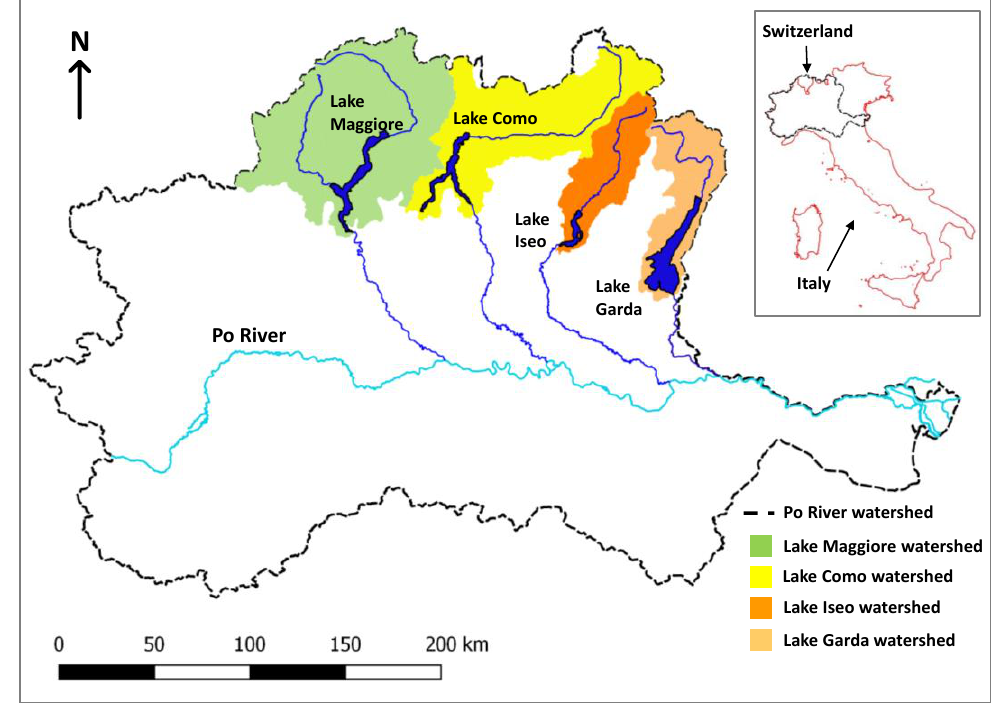
Figure 1. Location of the four subalpine lakes in Northern Italy and South Switzerland.